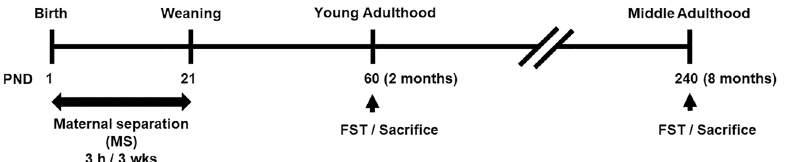
Figure 1. Experimental design timeline. Pups were separated from their mothers for 3 h daily from postnatal day (PND) 1 to PND 21. When the pups reached young adulthood (2 months) or middle age (8 months), they were subjected to the forced swimming test (FST). Following the FST, the mice were sacrificed immediately for the p11 molecular analysis. Molecular analysis was measured within the same batch experiment in all groups.